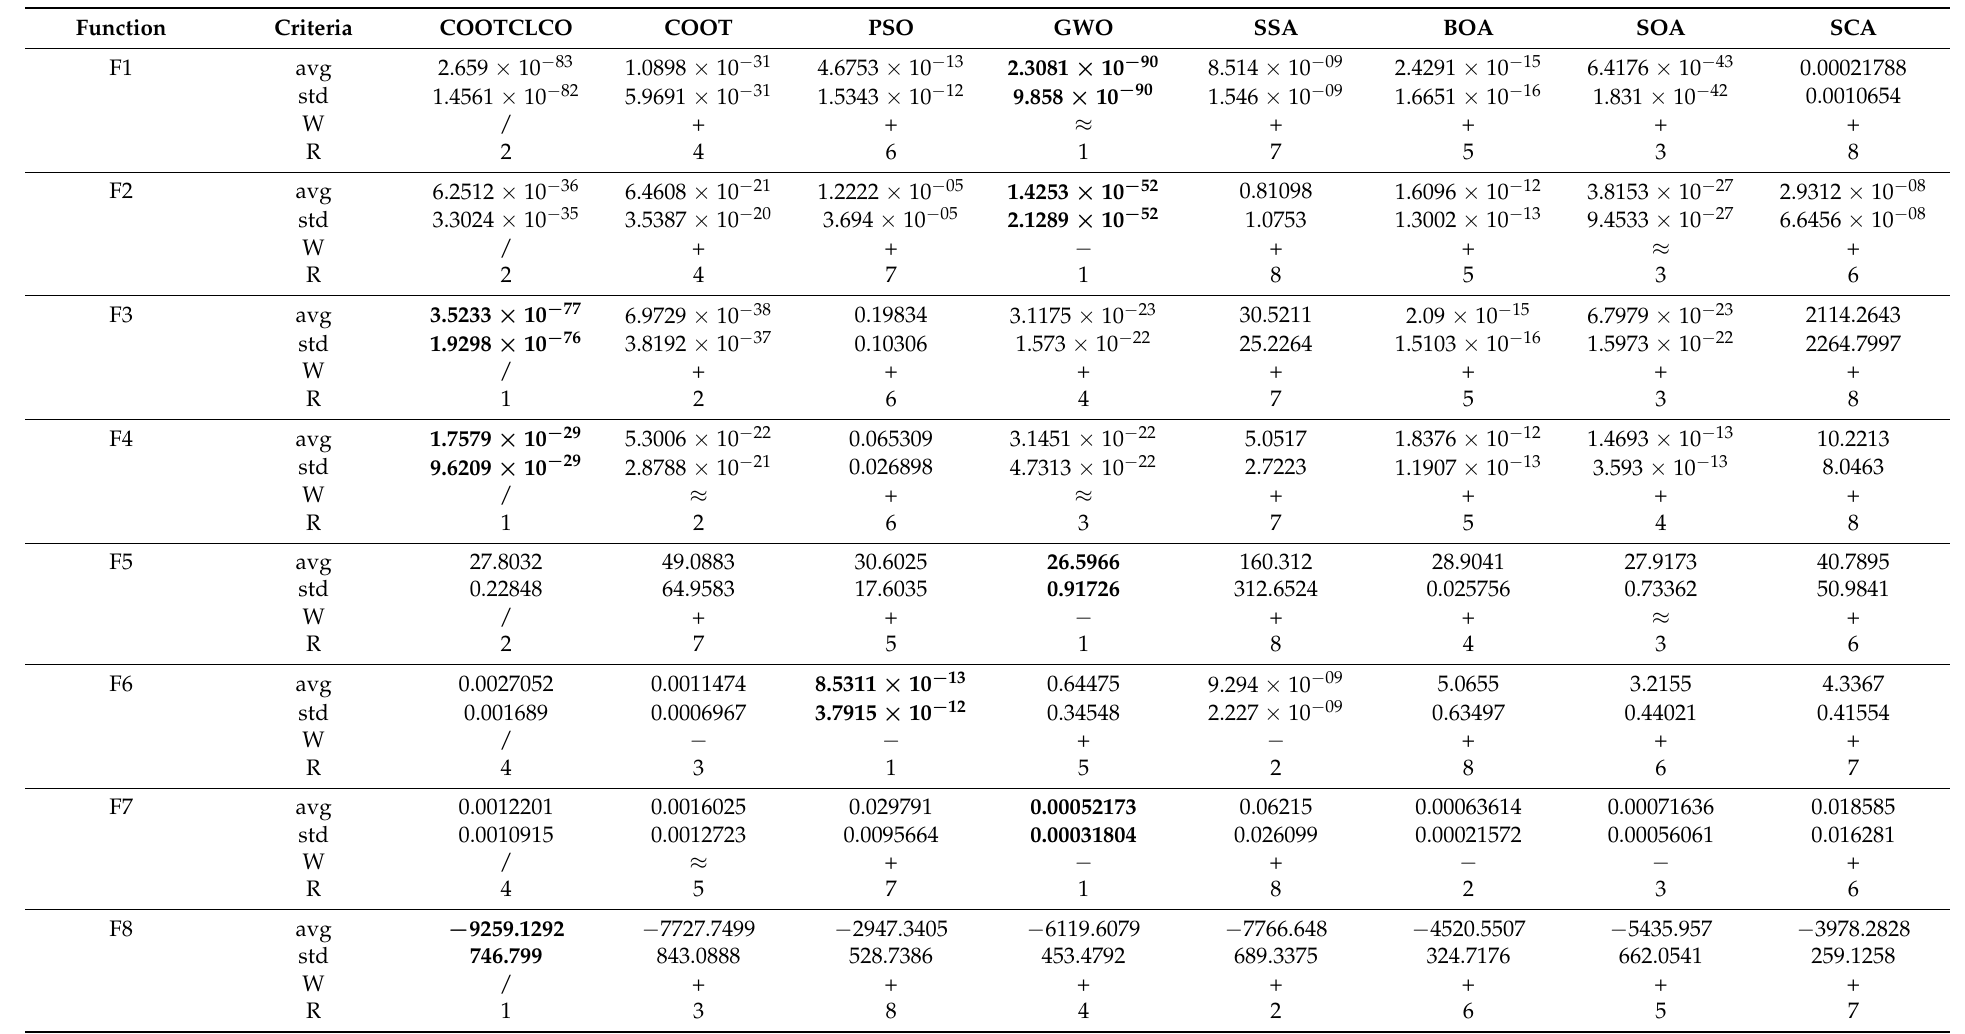
Table 6. Results of unimodal and multimodal benchmark